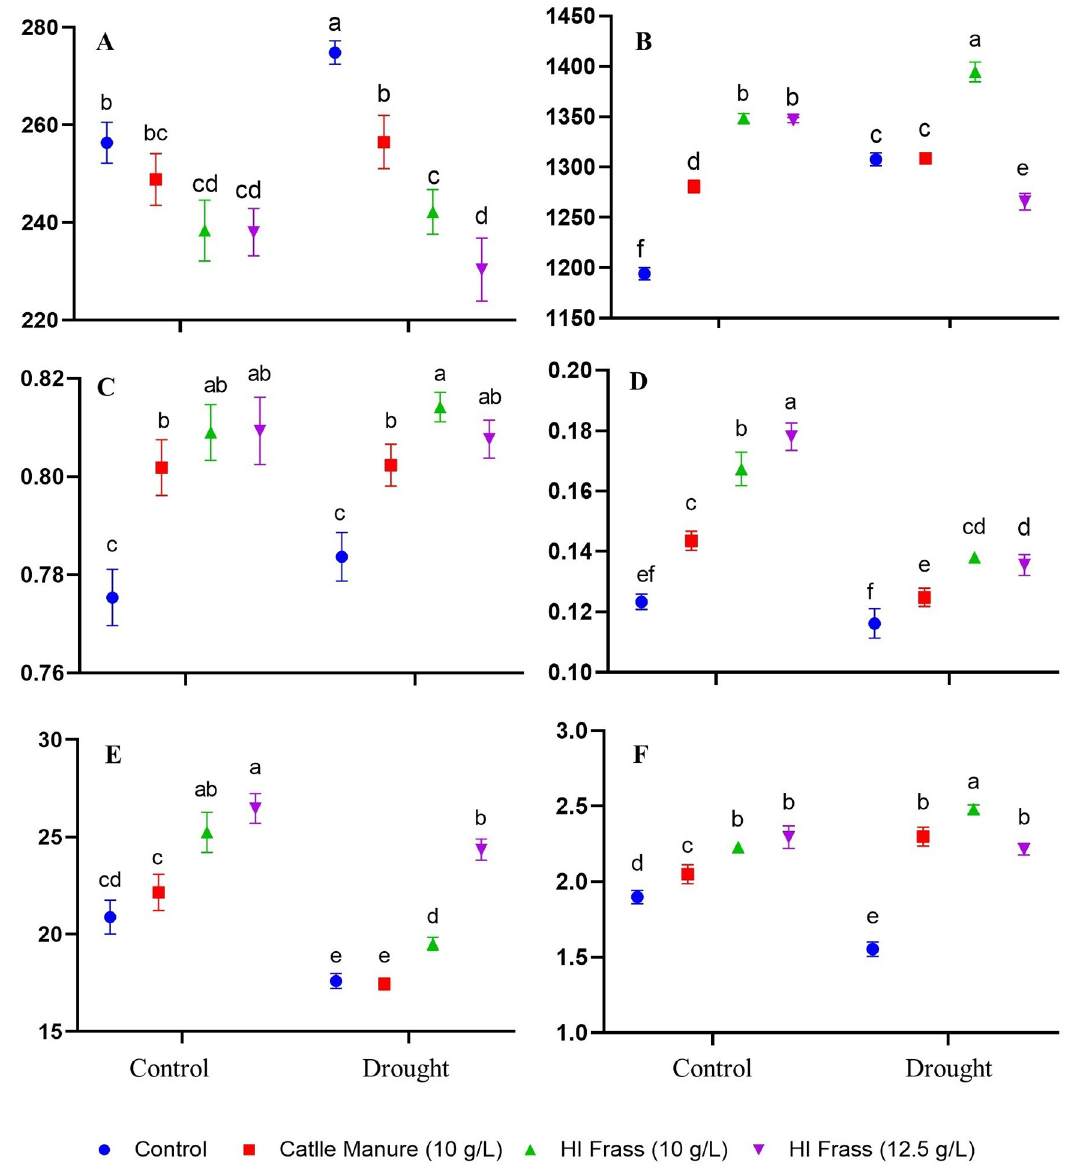
Fig 1. Parameters of chlorophyll fluorescence of the basil plants cultivated under two water regimes and using various fertilizer formulations. Parameters assessed after dark adaptation: A- minimum fluorescence (F0), B- maximum fluorescence (Fm), C- maximum photochemical efficiency of PSII (Fv/Fm). Parameters assess in the light: D- quantum yield of photosynthetic energy (Yield), E- Electron Transport Rate (ETR) and F- non-photochemical quenching (NPQ) [non-nominated units]. Letters a-f indicate statistically different mean values ( α = 0.05). F0: LSD Stress : 8.16; LSD Fertilizer : 8.15; LSD Stress � Fertilizer : 9.38. Fm: LSD Stress : 33.16; LSD Fertilizer : 46.06; LSD Stress � Fertilizer : 11.62. Fv/Fm: LSD Stress : 0.008; LSD Fertilizer : 0.006; LSD Stress � Fertilizer : 0.0095. Yield: LSD Stress : 0.0098; LSD Fertilizer : 0.0163; LSD Stress � Fertilizer : 0.007. ETR: LSD Stress : 1.55; LSD Fertilizer : 2.49; LSD Stress � Fertilizer : 1.29. NPQ: LSD Stress : 0.163; LSD Fertilizer : 0.152; LSD Stress � Fertilizer : 0.095. NPQ as a result of drought was recorded only in the non-fertilized basil plants. In plants fertil- ized with manure and HI frass at a dose of 10 g/L, an increase in the NPQ value was observed, whereas in those fertilized with HI frass at the higher dose, no significant differences vs, non- fertilized controls were found.